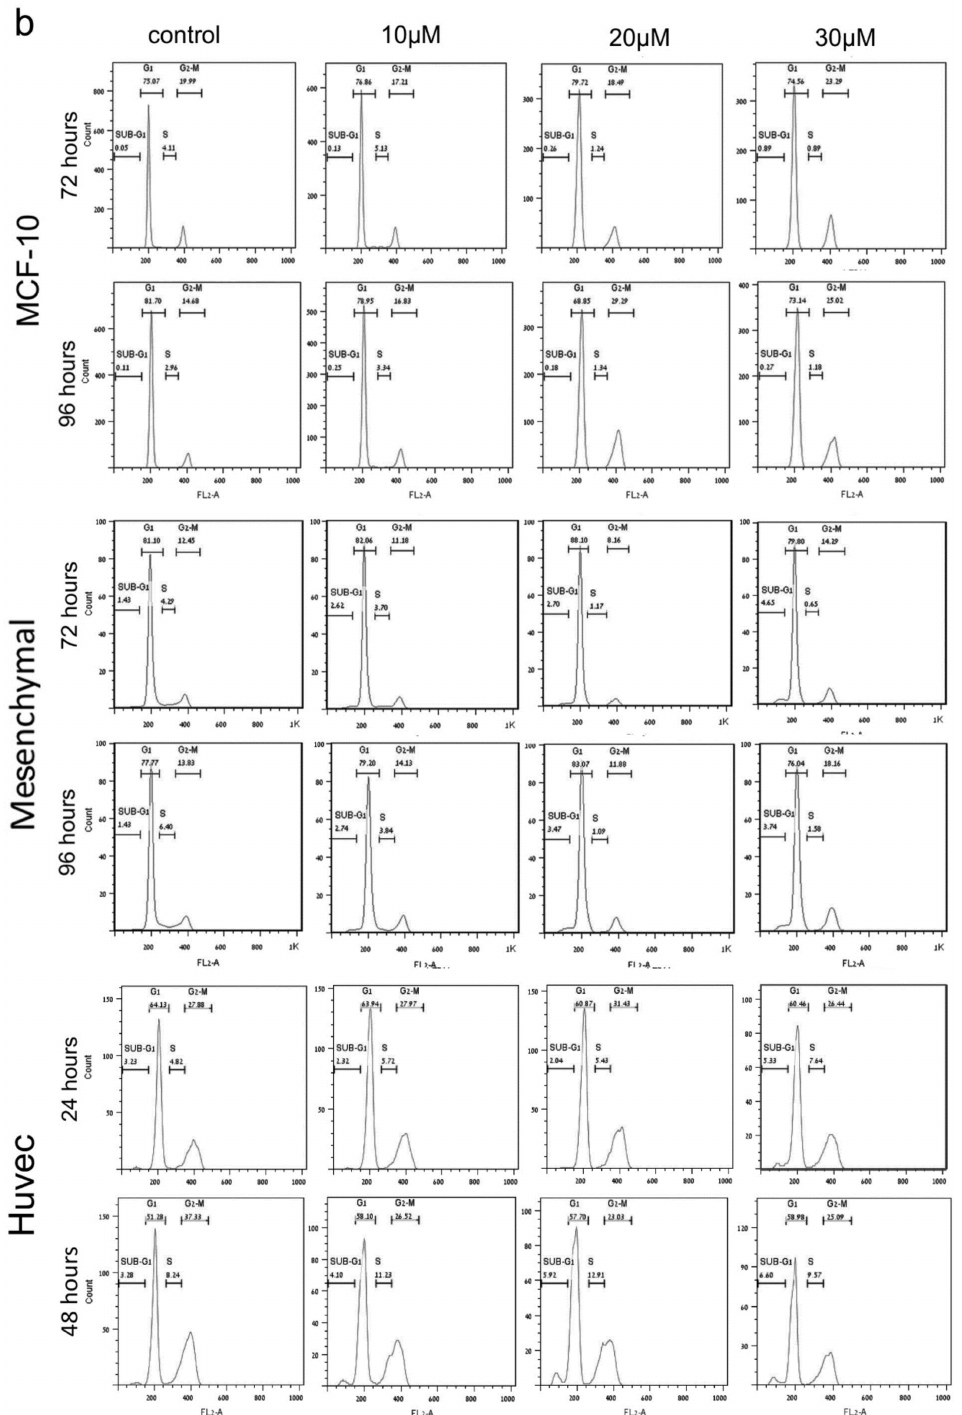
Figure 2. G2 / M arrest and cell death in human cancer cells treated with PJ34. PJ34 does not impair the cell-cycle of human healthy proliferating cells. Flow cytometry of the indicated human cancer cells ( a ) and human healthy proliferating cells ( b ) is displayed. Cells were treated with PJ34 at the indicated concentrations and incubation periods. From: Castiel et al., 2011, BMC Cancer